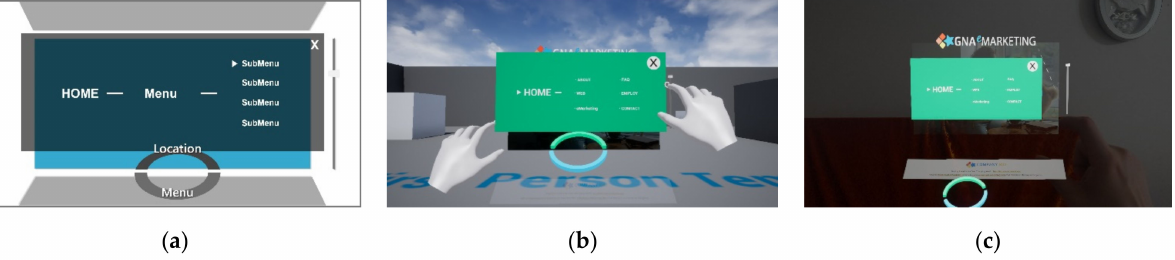
Figure 12. Location panel details: ( a ) Location panel concept [21]; ( b ) Location panel prototype (VR); ( c ) Location panel prototype (MR).